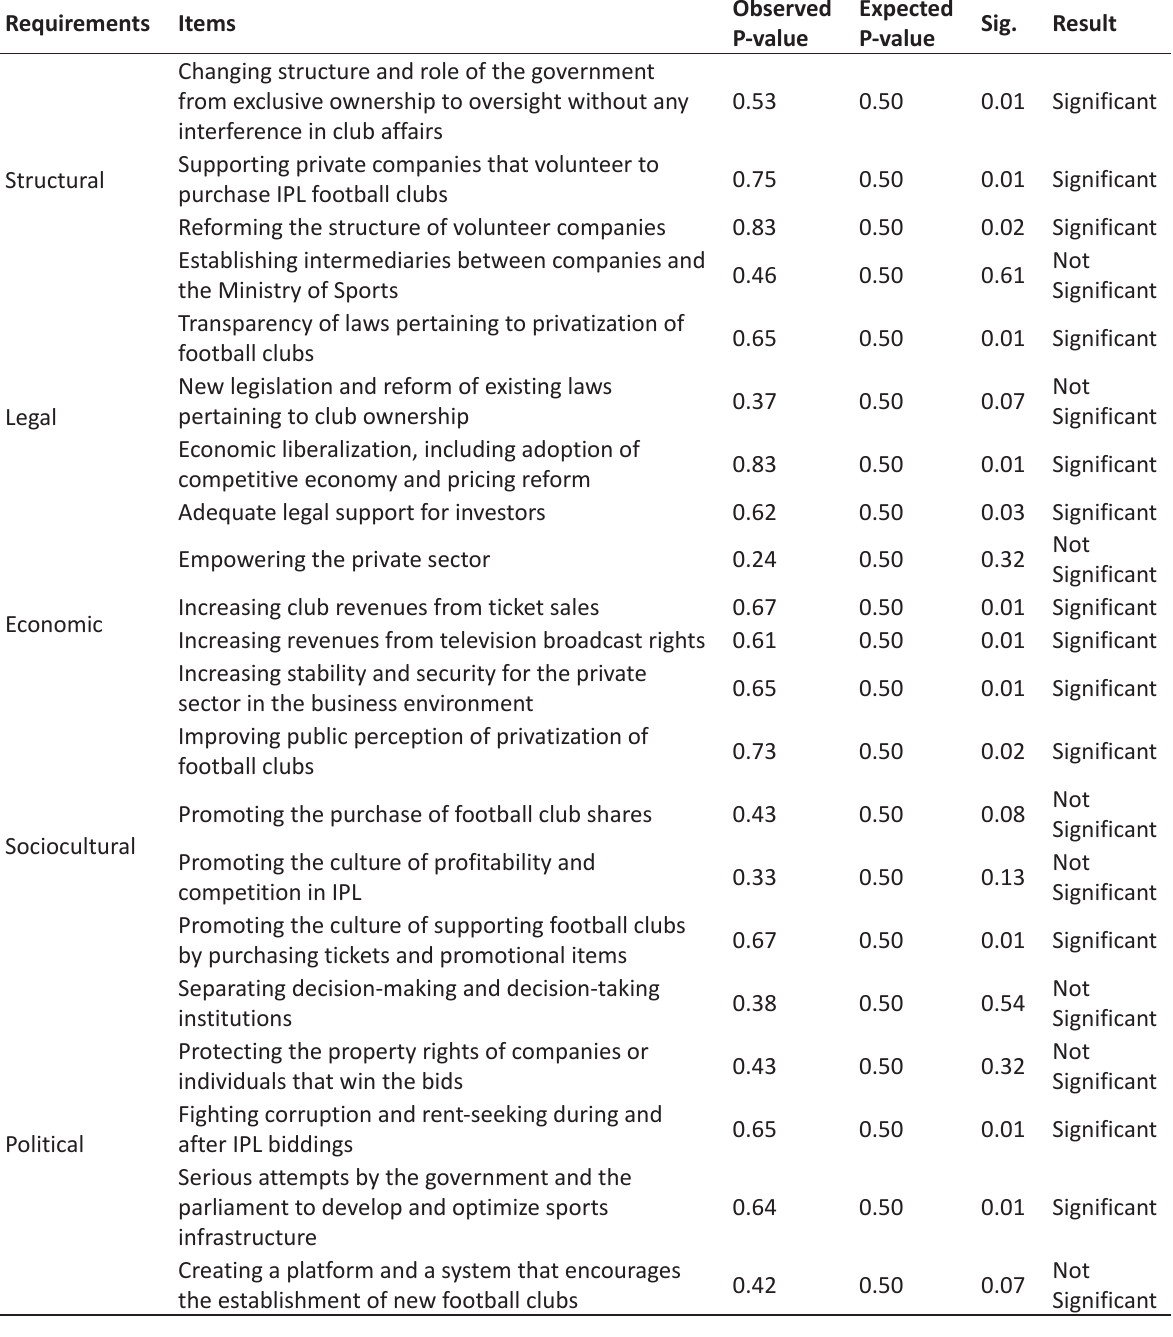
Table 2. The results of binomial test Requirements